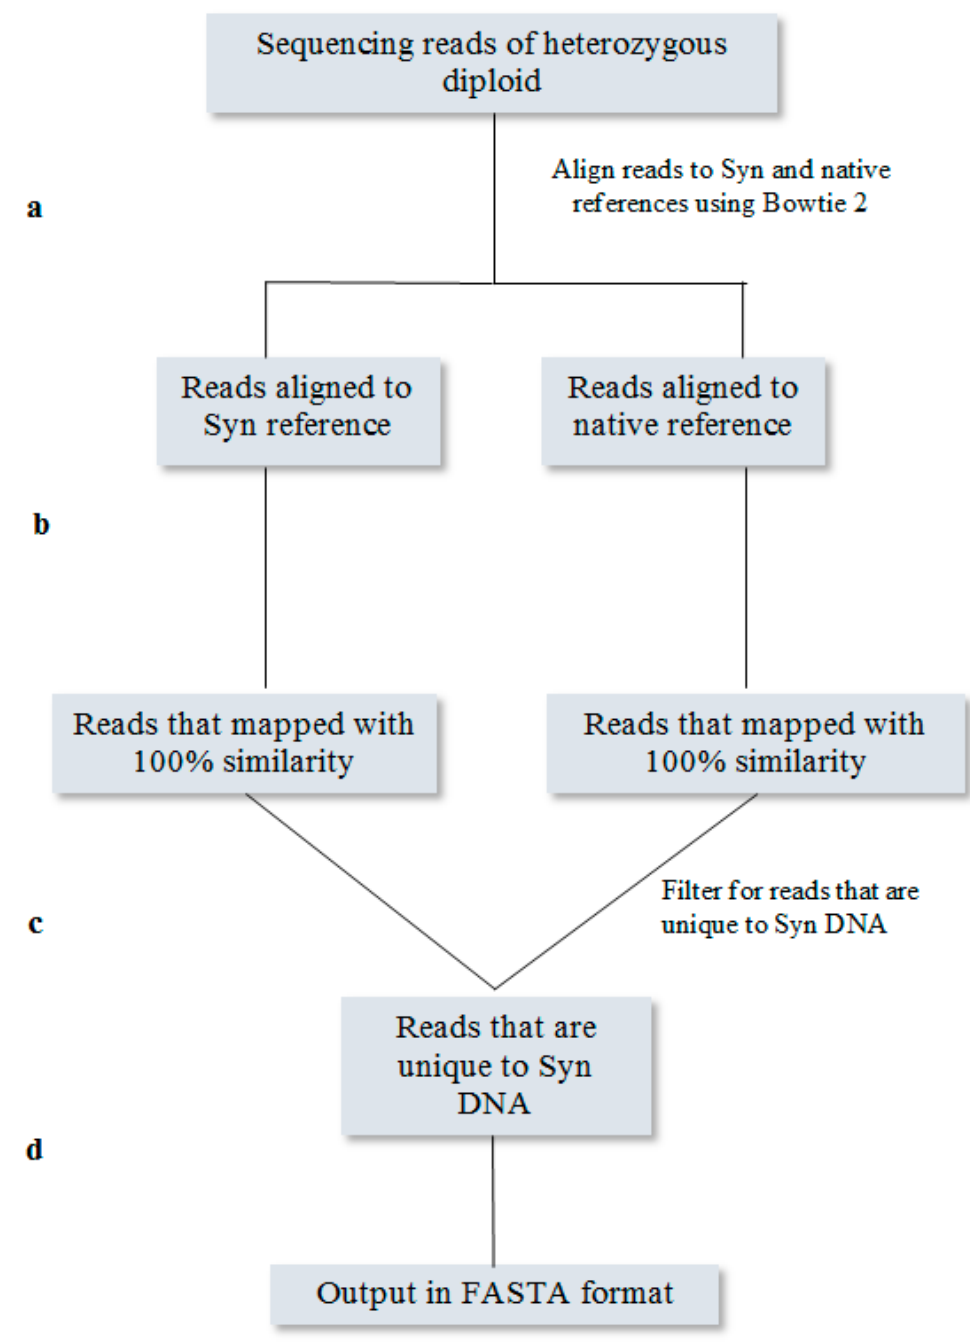
Figure A4. Summary of bioinformatics pipeline to filter sequencing reads of SCRaMbLEd heterozygous diploid S. cerevisiae . Reads are mapped to reference sequences from both parental chromosomes ( a ) and are filtered by reads that were a 100% match to the reference ( b ). Pools of reads are compared and reads that uniquely match to the synthetic reference are separated ( c ). The final read pool is converted into FASTQ for convenient direct use in other software ( d ). Table A1. Primers used in this study.